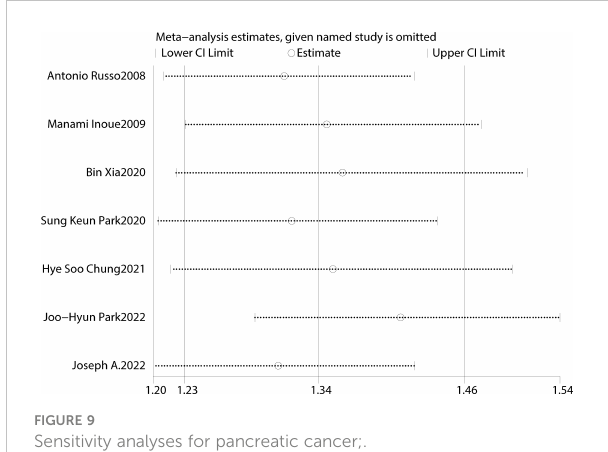
FIGURE 9 Sensitivity analyses for pancreatic